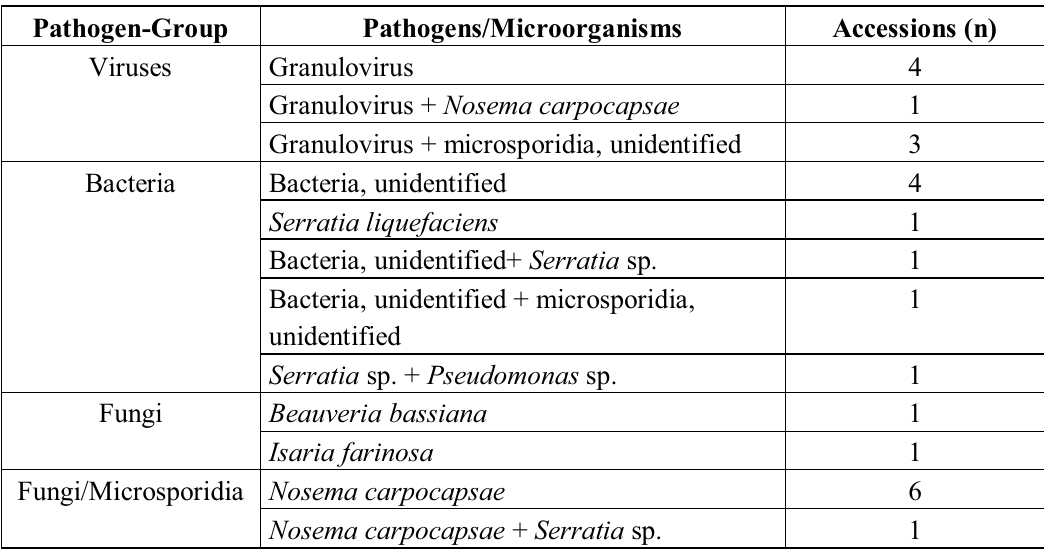
Table 2. Diagnosed pathogens and other microorganisms in C. pomonella (larvae, pupae, adults), from laboratory